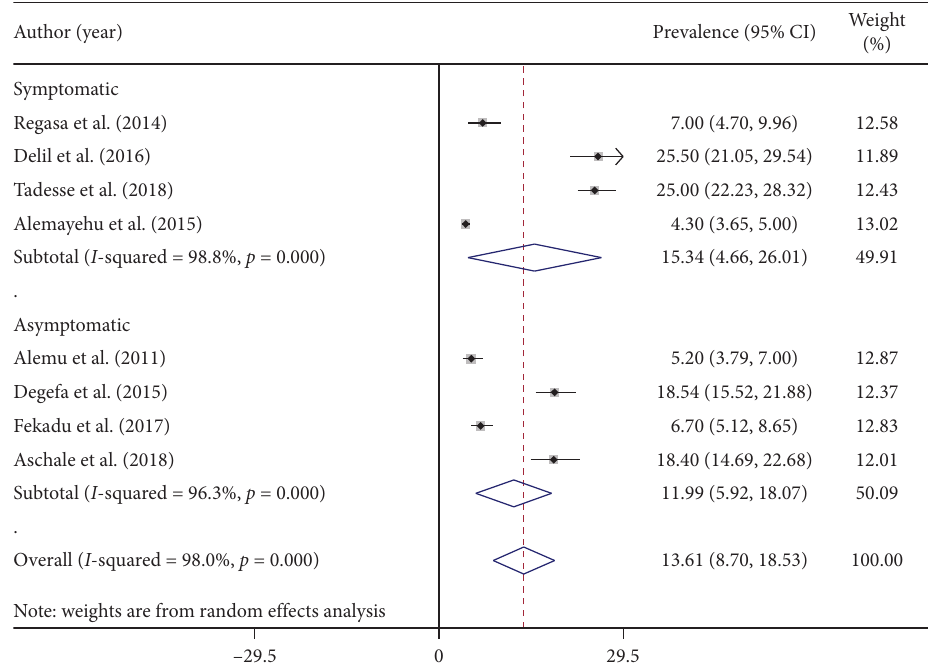
Figure 3: Forest plot showing the combined malaria pooled prevalence estimate among adults by types of study participants in